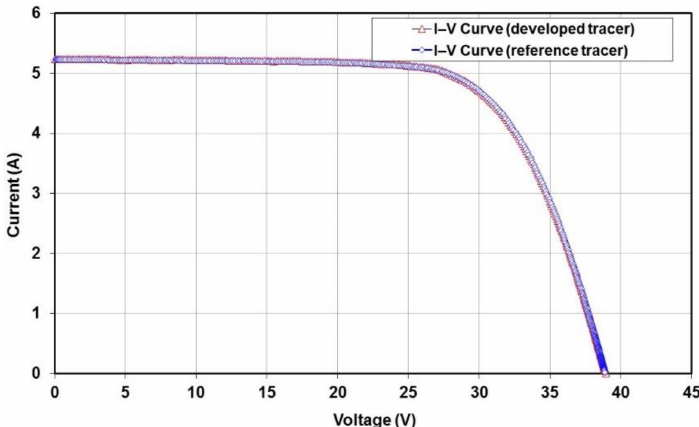
Figure 14. I–V curves obtained simultaneously between the developed tracer and the reference tracer for the polycrystalline silicon PV module.